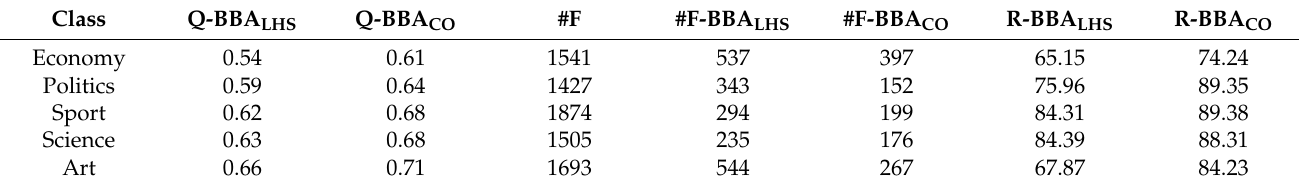
Table 21. Characteristics of the selected feature sets in Al-Jazeera news dataset, where Q indicates the quality of feature set, #F indicates number of features, R indicates reduction rate (%).